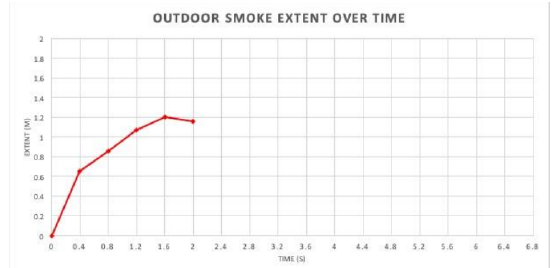
Figure 15. 2D Graph of Cigarette Smoke Extent vs Time in an Outdoor Environment